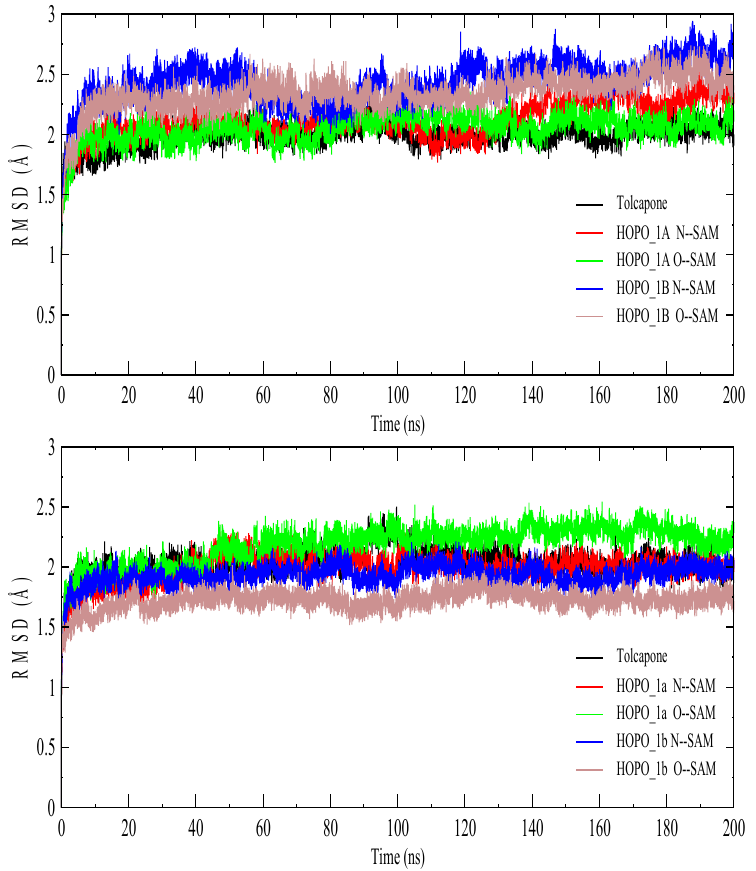
Figure 7. RMSD time series along the simulations. Top figure, the simulations with rat COMT, bottom figure, the simulations with human COMT.